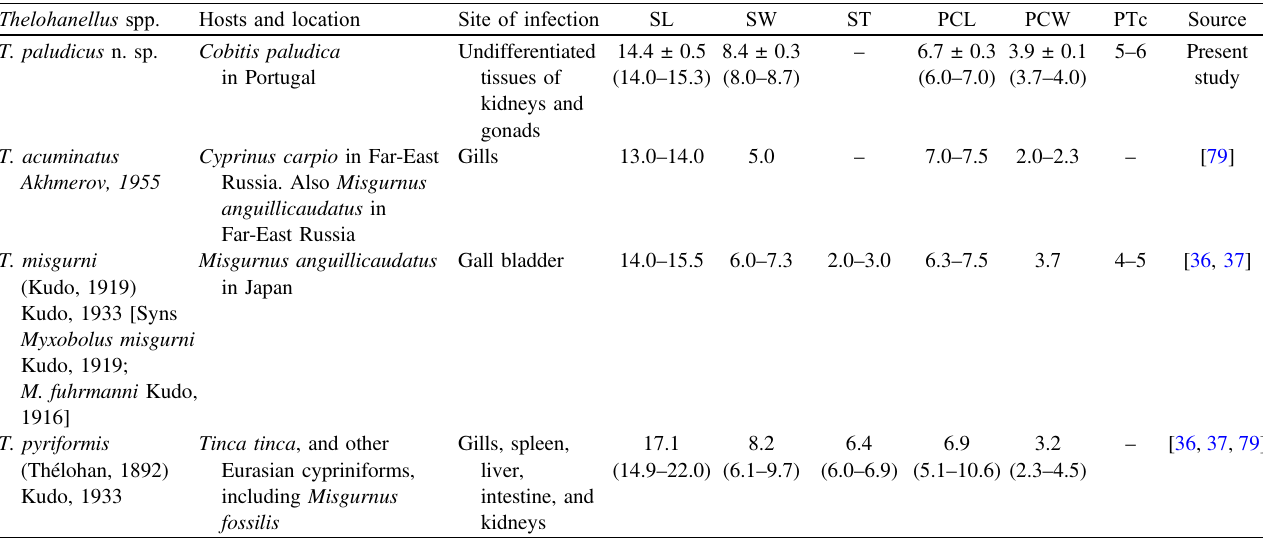
Table 3. Comparison of T. paludicus n. sp. to other Thelohanellus spp. from cyprinid fi sh hosts of the subfamily Cobitinae. Thelohanellus